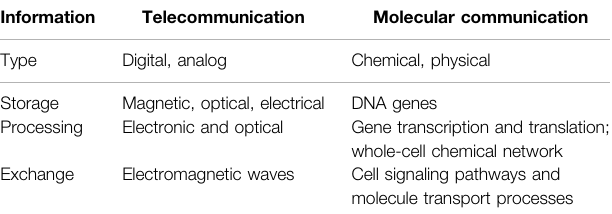
TABLE 1 | Information transmission, reception, and processing in Telecommunication and MC Systems.